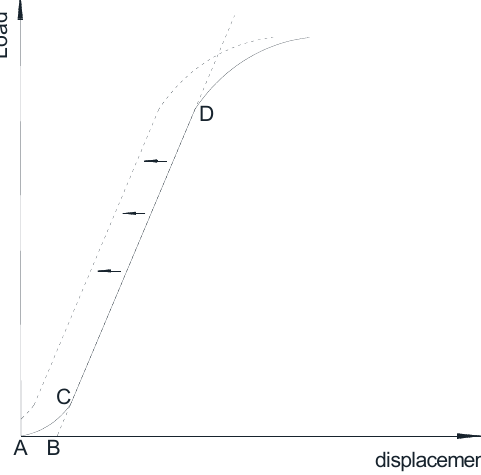
Figure 9. Offset of the experimental load-displacement curve.